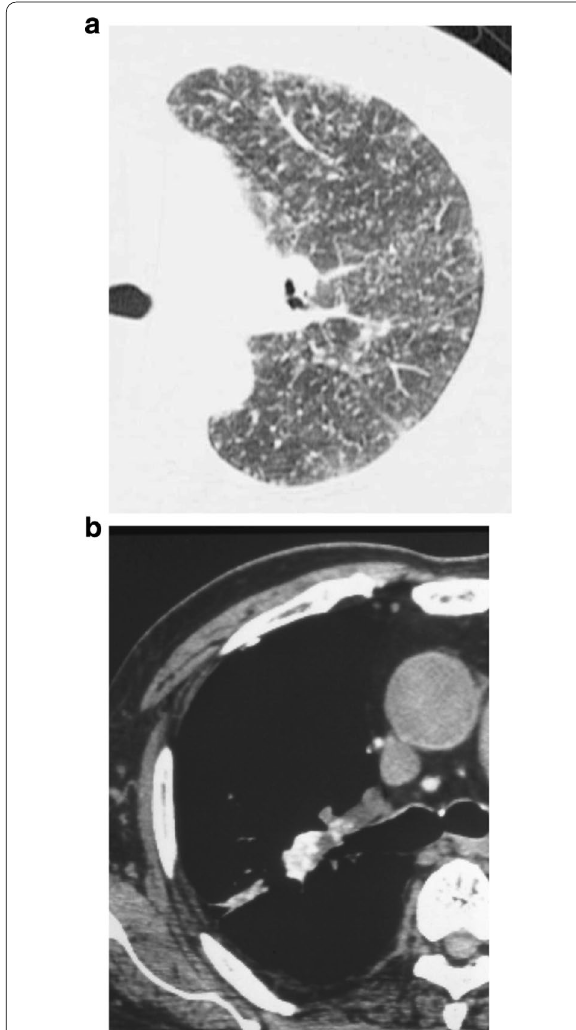
Fig. 3. 61-year-old man with inhalational talc pneumoconiosis employed in talc industry for 20 years. a HRCT scan shows diffusely distributed small nodules. They are separated from the pulmonary vein or the pleura at a distance of about 2–3 mm and are separated regularly from each other at a distance of about 2–3 mm. b CT scan at mediastinal setting of 61-year-old man with inhalational talc pneumoconiosis shows large opacity and lymph nodes containing high-attenuation material